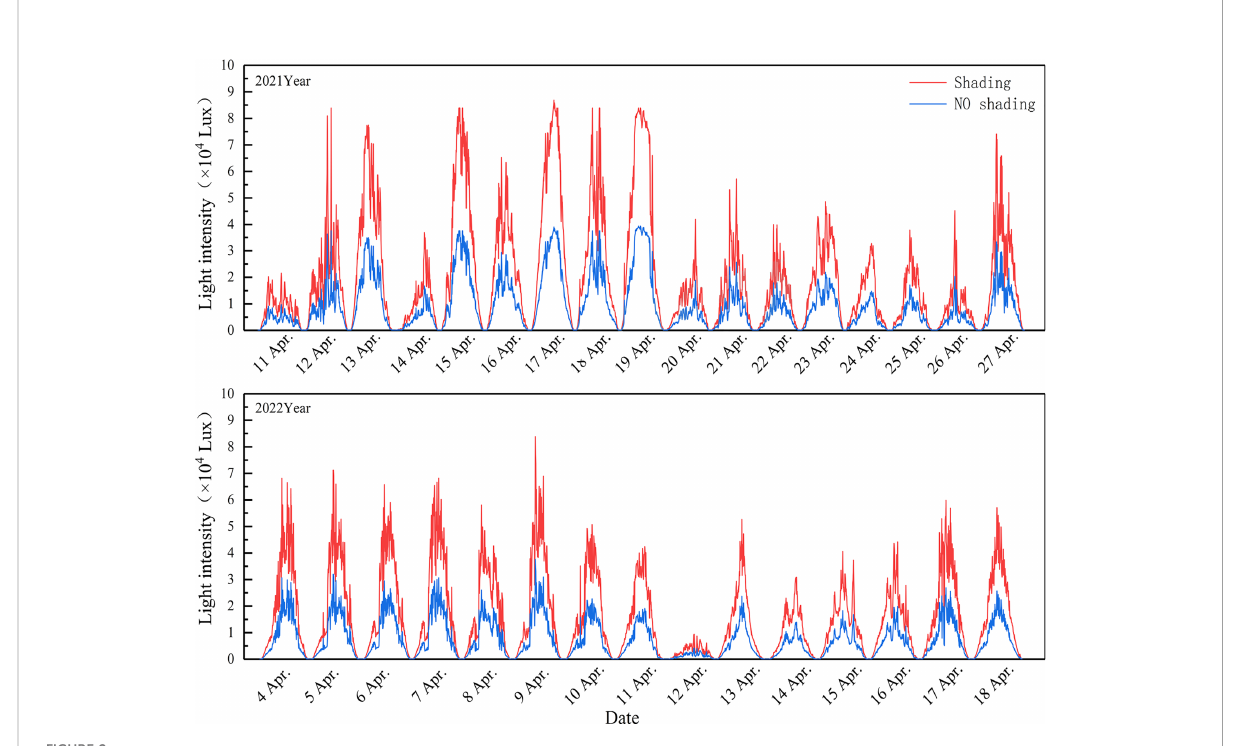
FIGURE 2 Changes of light intensity under shading